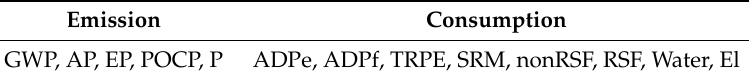
Table 2. Classes of